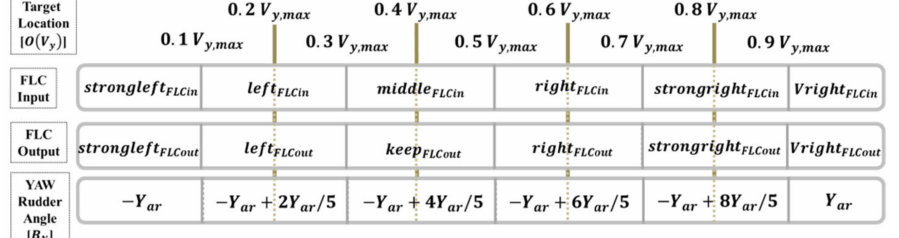
Figure 8. Relationship between the target’s image horizontal coordinate axis and the FLC yaw angle.